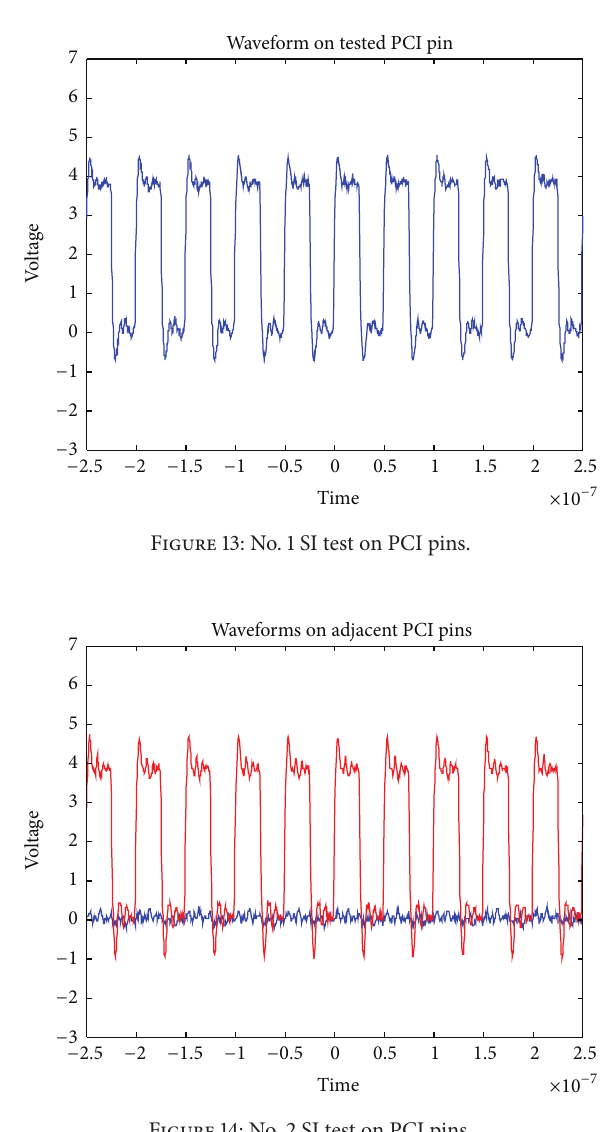
Figure 14: No. 2 SI test on PCI pins.